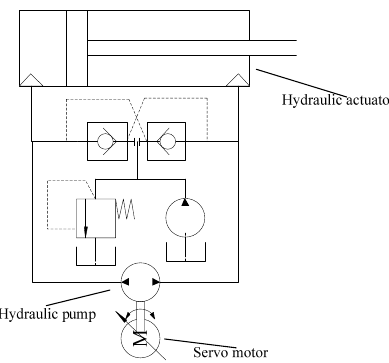
Figure 2. The schematic diagram of a traditional direct drive hydraulic system.